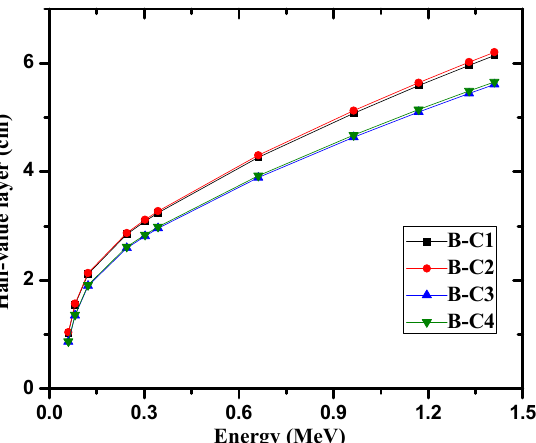
Figure 3. The Half-value layer of the four investigated samples at different energies.